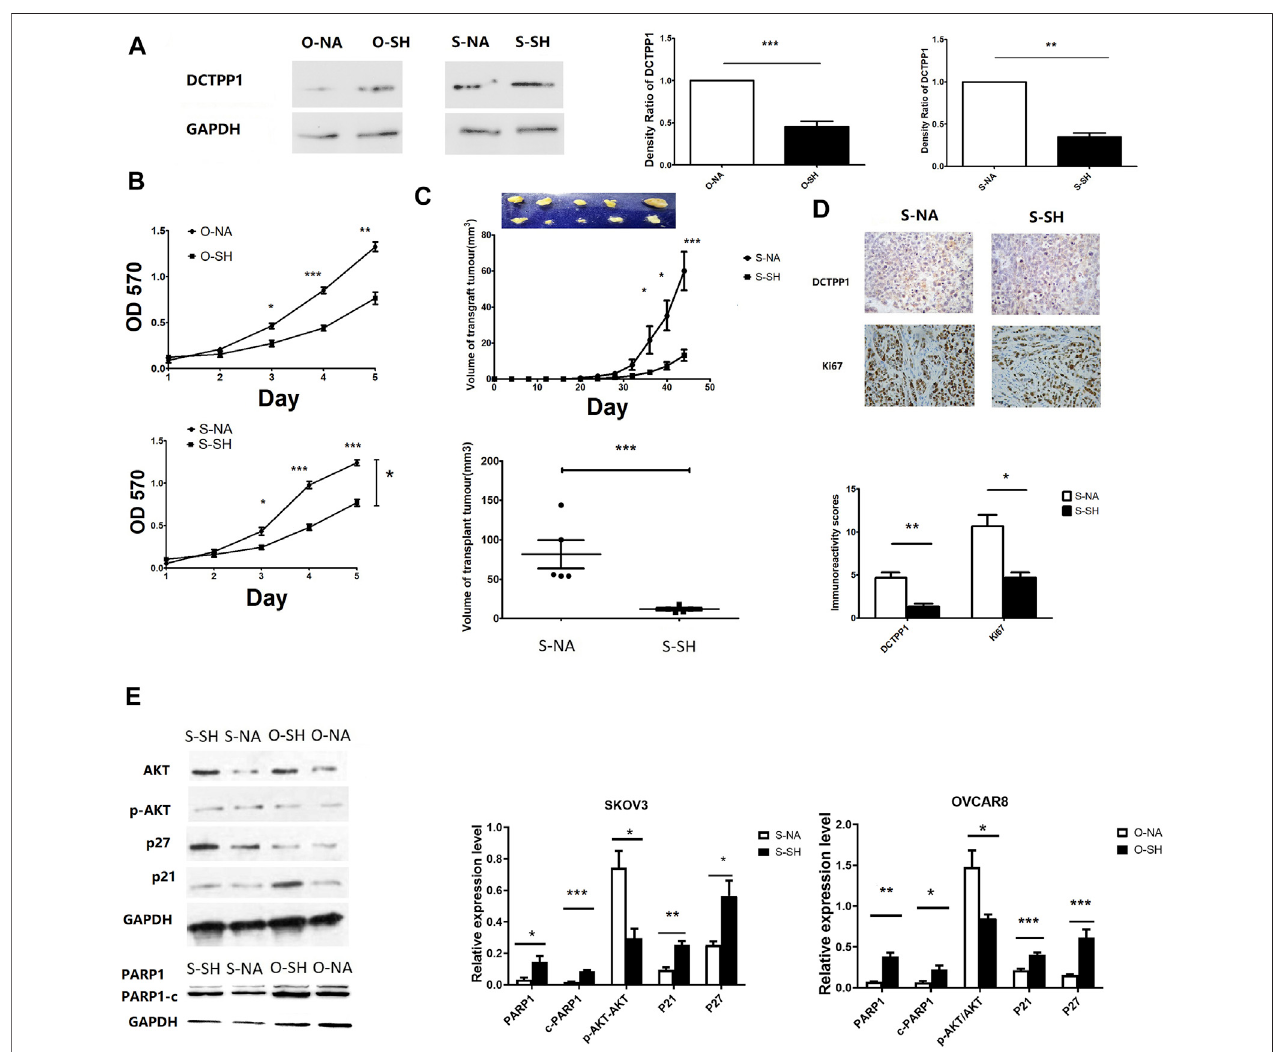
FIGURE3 | Knockdown ofDCTPP1inhibits tumor growth viaregulating theAkt pathway. (A) Western blot analysisand densitometric quanti fi cation ofDCTPP1 in SKOV3 and OVCAR8 cells treated with shRNA against DCTPP1. **, p < 0.01; ***, p < 0.001; (B) Growth curve of SKOV3 and OVCAR8 cells with the indicated shRNA transpected.* p < 0.05; **, p < 0.01; ***, p < 0.001; (C) Up:Mean tumor growth curves for xenografts from SKOV3 cells transfected with shRNA and the control respectively. * p < 0.05,***, p < 0.001; compared to S-NA; Down: Mean tumor volume of xenografts from SKOV3 cells transfected with shRNA and the control respectivelyat6 weeks***, p < 0.001; (D) .DCTPP1andKi67immunohistochemistryinSKOV3cellstransfectedwithshRNAandthecontrolrespectively;* p < 0.05;**, p < 0.01; (E) Western blot analysis and densitometric quanti fi cation of P21,P27,PARP1,c-PARP1,Akt,p-Akt in ovarian cancer cells transfected with shRNA and the control respectively. Data are presented as mean ± SEM.* p < 0.05; **, p < 0.01; ***, p <